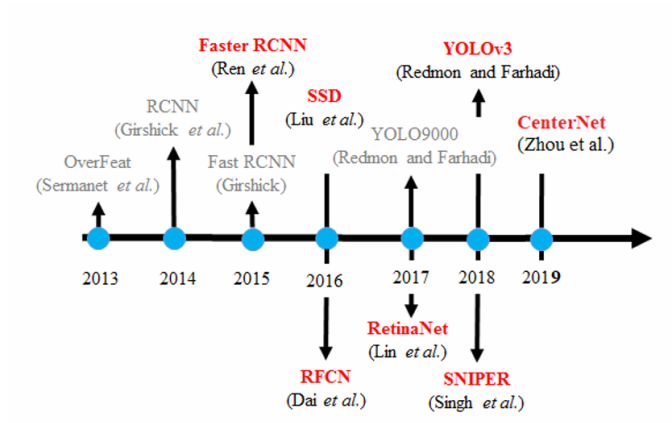
Figure 1. Timeline of state-of-the-art object detection methods. The benchmarked methods are marked in red and boldfaced font.